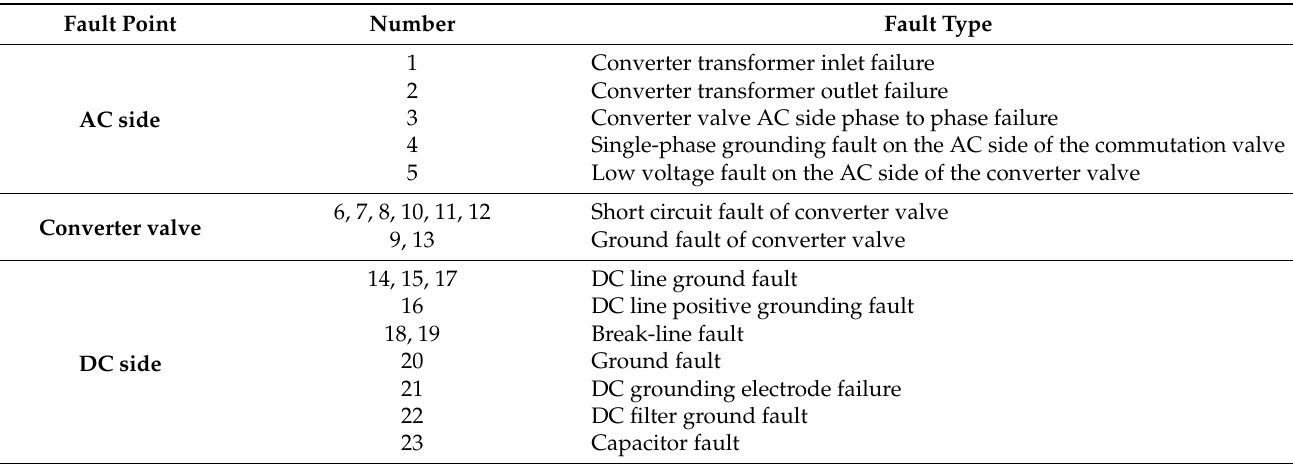
Table 2. Major fault points of a typical HVDC